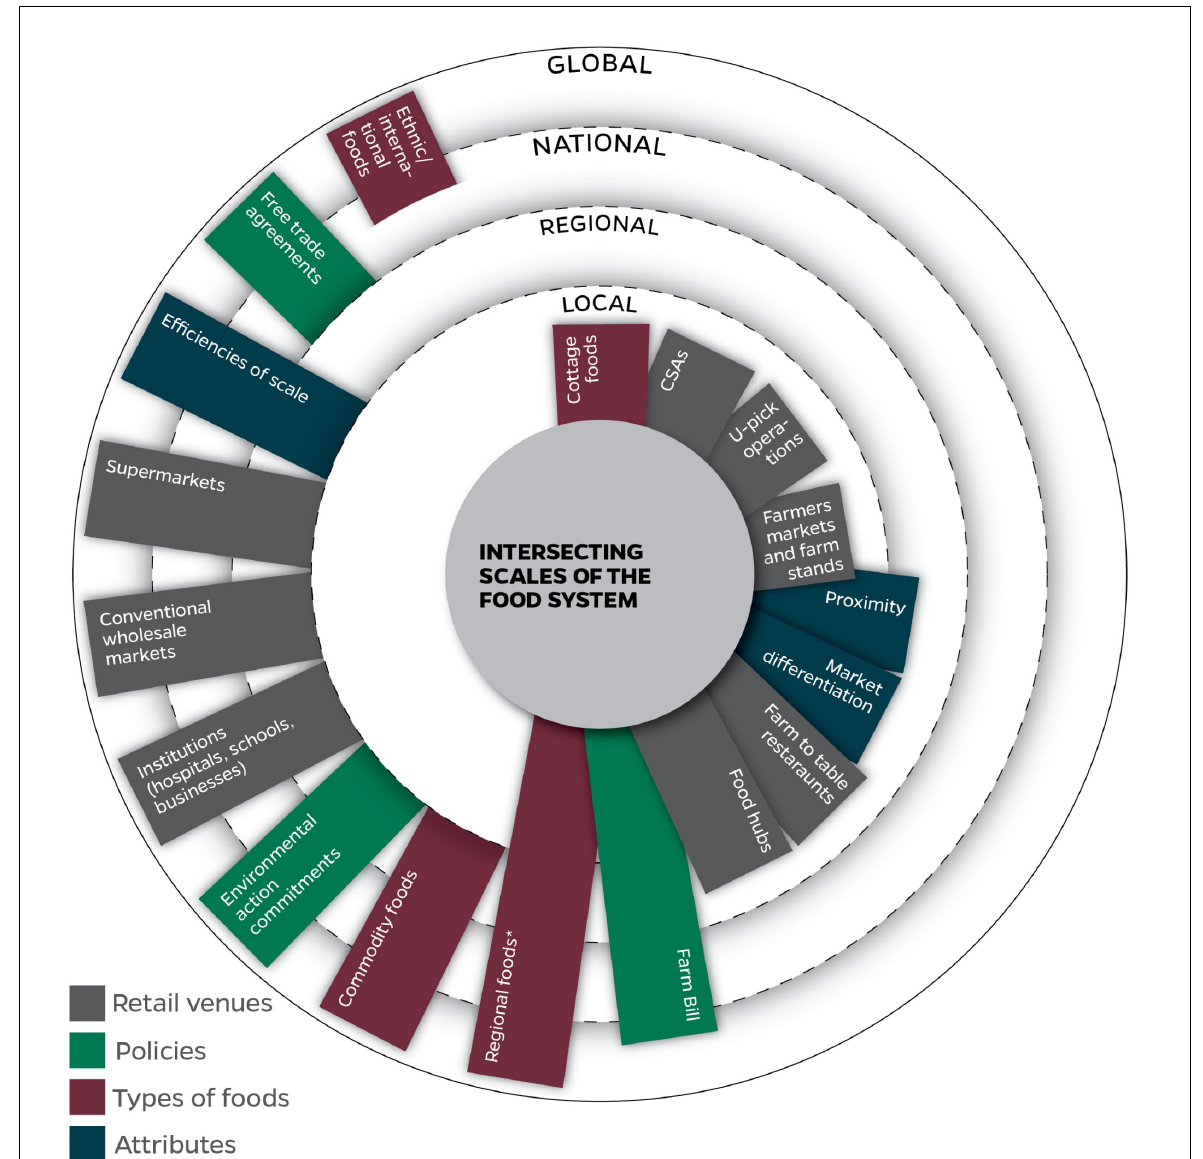
Figure 1. Visualizing Different Scales of the Food System Retail venues, attributes, policies, and types of food are identified with the scale of the food system with which they are most closely associated. For instance, while some supermarkets sell “local” food, they are most likely selling food within a radius more typically defined as their region (and are generally operating through regional wholesalers, not through direct farm-to-supermarket interactions). Meanwhile, while free-trade agreements influence local-level policies, they concentrate on national and international supply